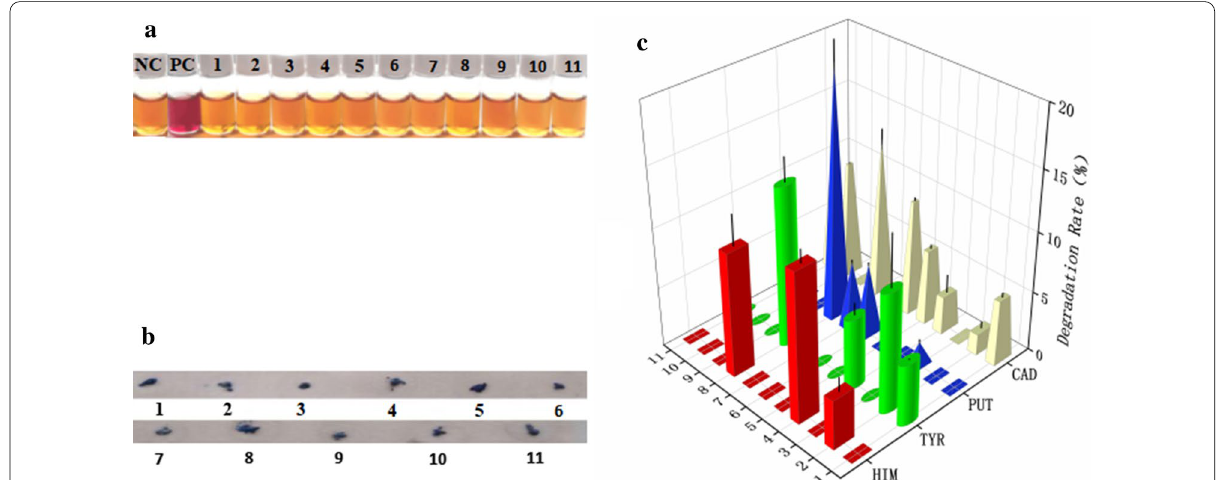
Fig. 1 Screening of BA-degrading strains in Gssp (the numbers in the figure are the order of the strains): a Decarboxylase activity, negative reaction: yellow, the negative control (NC) is a medium without any bacterial cells; positive reaction: purple, the positive control (PC) strain is Bacillus clausii . b AO activity. c Evaluation of BA degradability, data are the means standard deviations from three ±